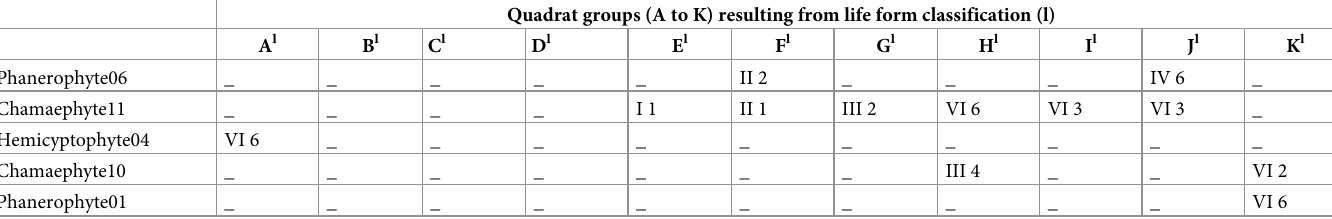
The Roman number corresponds to species constancy within each TWINSPAN group (I = 5% or less; II = 6–20%; III = 21–40%; IV = 41–60%; V = 61–80%; VI = 81– 100%). The Arabic number indicates average species abundance for each group on the domin scale (1 = less than 1%; 2 = 1–4%; 3 = 5–10%; 4 = 11–25%; 5 = 26–50%;